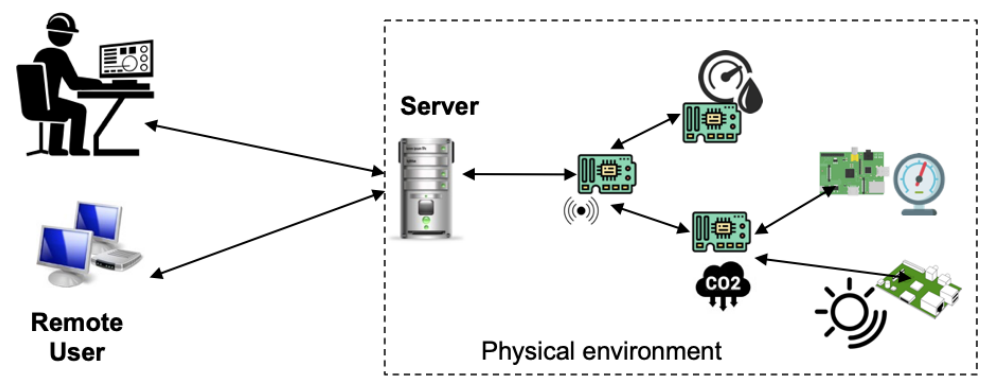
Figure 1. System overview.